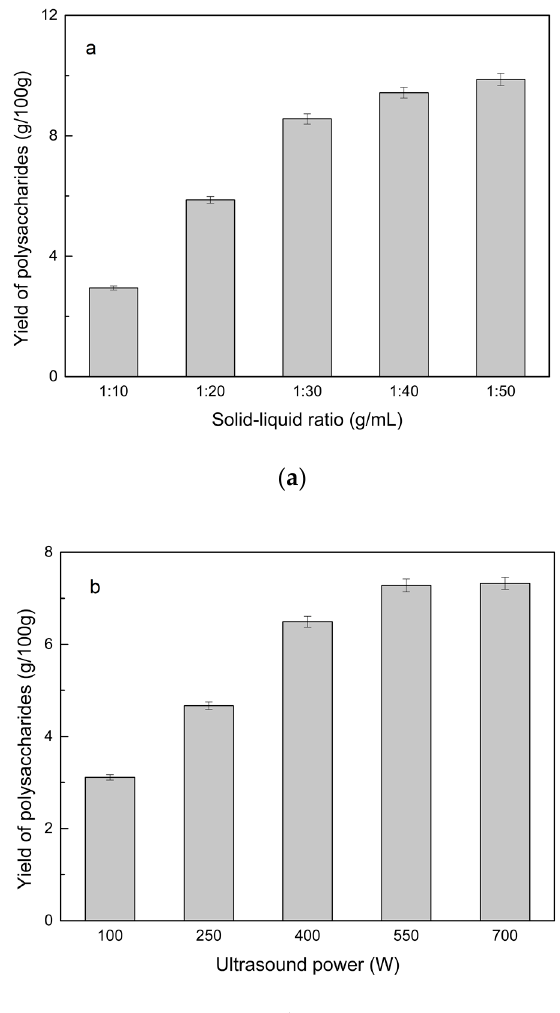
Figure 2. Kinetic study of polysaccharide